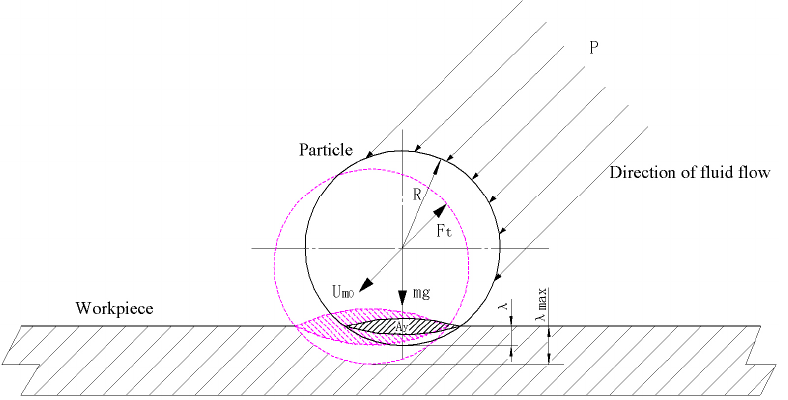
Figure 8. A motion diagram of an abrasive particle before reaching the lowest point of indentation.